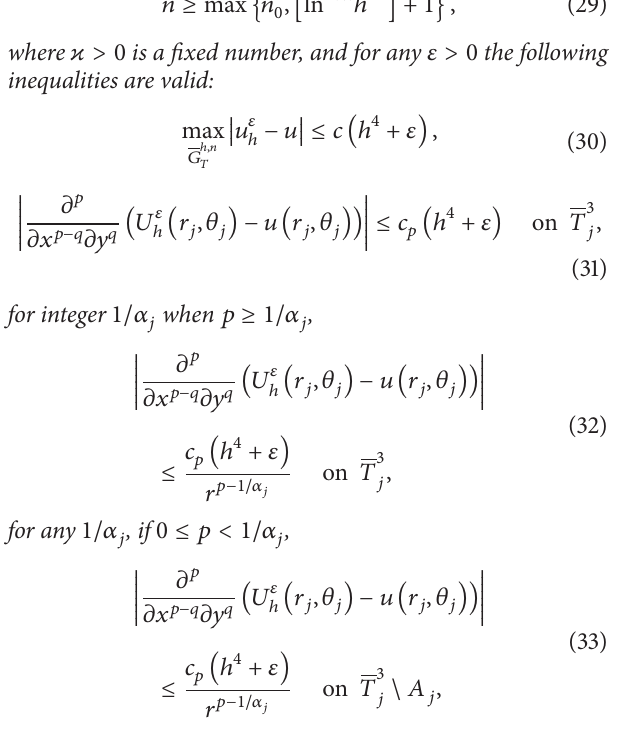
Table 1: The order of convergence in the “nonsingular” part when ℎ = 2 −󰜚 and 𝜀 = 5 × 10 −13 . (2 −󰜚 ,𝑛) ‖𝜁 𝜀 (2 −4 ,60) 1.609 × 10 −8 15.577